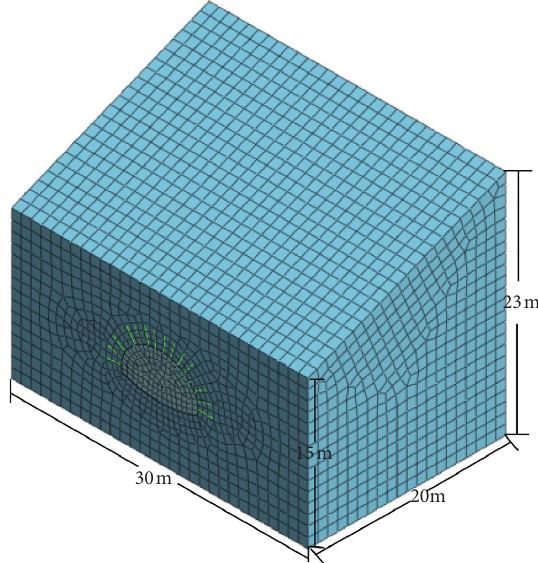
Figure 7: Finite element model size. Table 2: Scheme parameters based on the uniform design